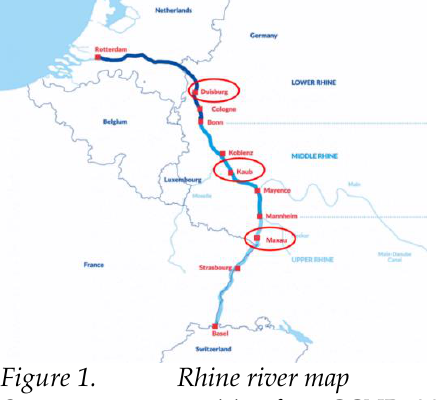
Figure 1. Rhine river